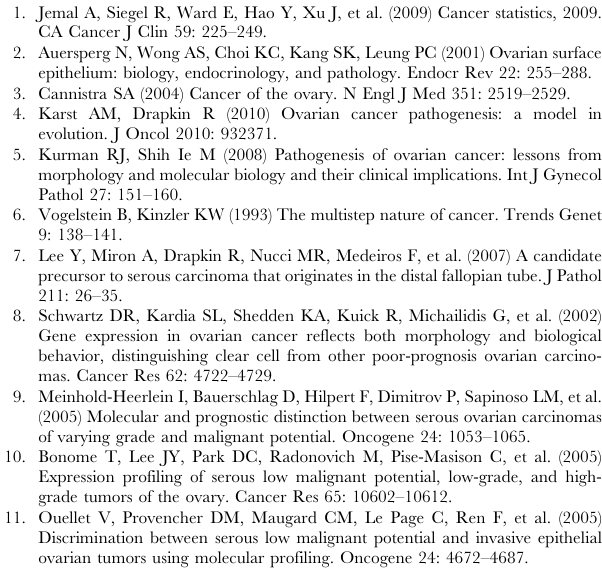
Table S1 Differentially expressed actin binding regu-